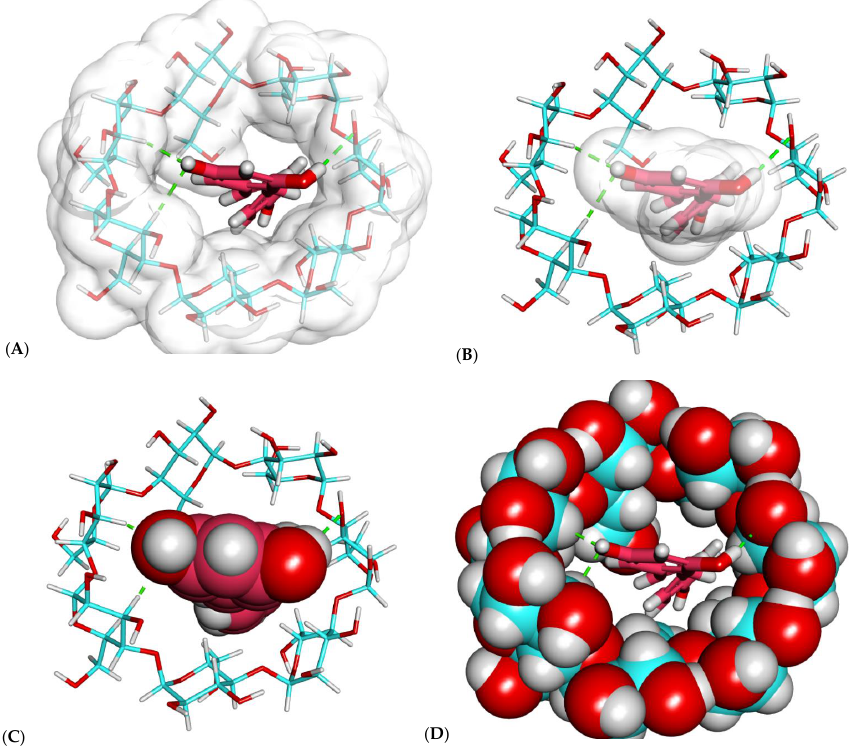
Figure 3. Docked poses of the best-ranked docking score of resveratrol with β -CD (top view): ( A ) resveratrol (sticks) and β -CD (sticks) pointing at β -CD, ( B ) resveratrol (sticks) and β -CD (sticks) pointing at resveratrol, ( C ) resveratrol (CPK) and β -CD (sticks), ( D ) resveratrol (sticks) and β -CD (CPK). As shown in Figures 2 and 3, the resveratrol was incorporated correctly inside the β - CD. However, one essential drawback emerged, as the size of resveratrol was greater than